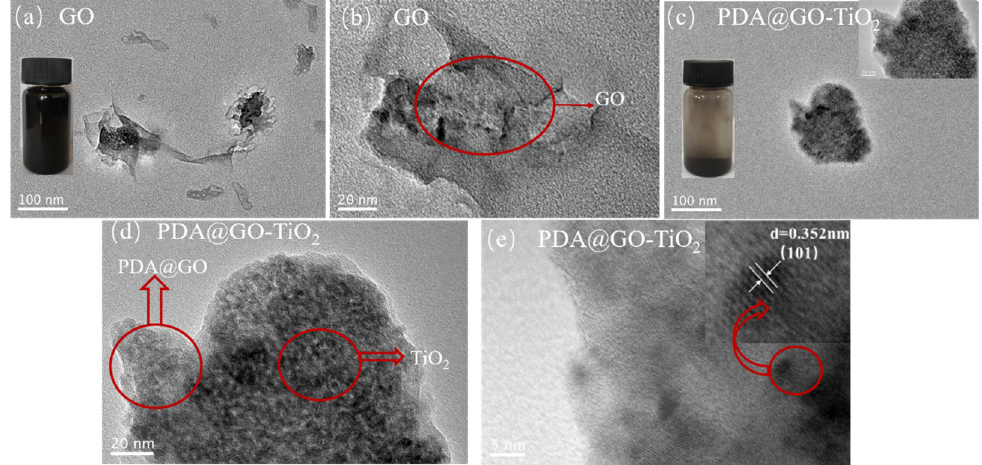
Figure 7. Transmission electron microscopy (TEM) images of GO (a), (b) and nano-PDA@GO-TiO 2 composites (c), (d), (e).